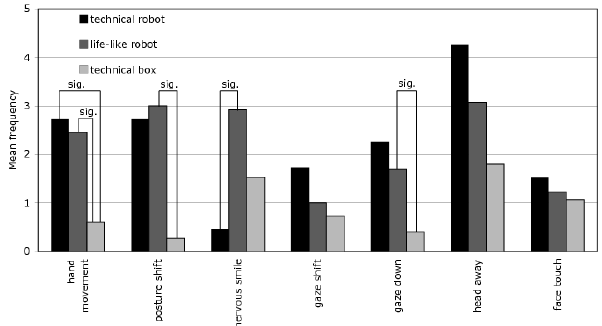
Figure 4. Count of behaviors across the experimental conditions. “sig.” indi- cates significant differences.